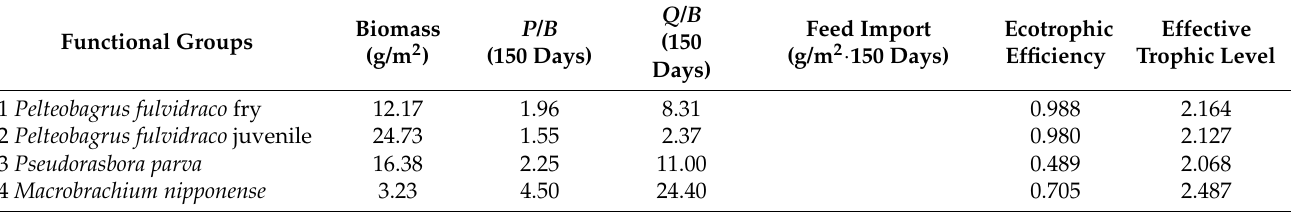
Table 2. Basic estimates of the Ecopath